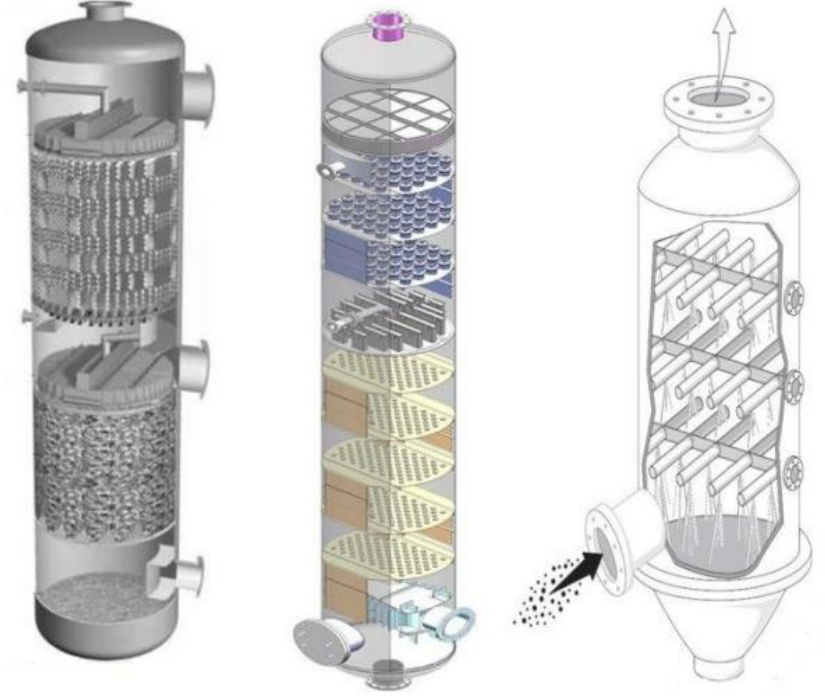
Figure 1. General view of a heat and mass transfer apparatus for the separation of volatile impurities from liquid mixtures.